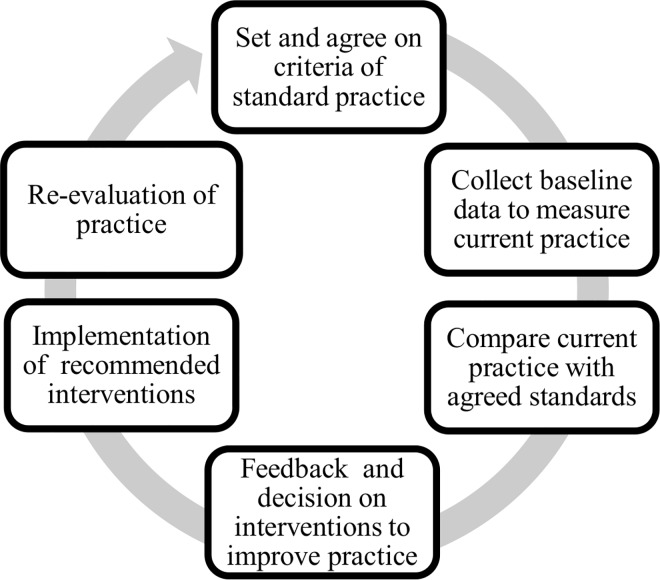
Criteria-based audit cycle.